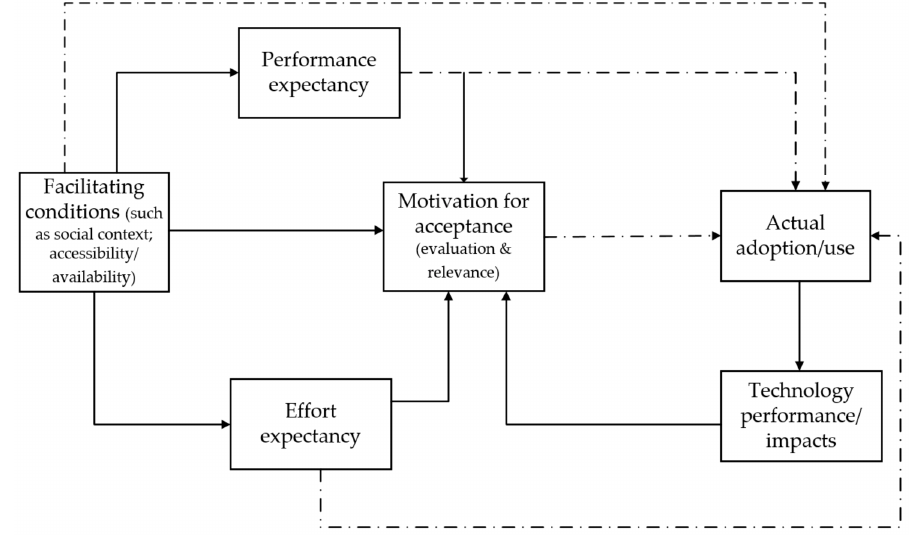
Figure 2. The proposed theoretical model.